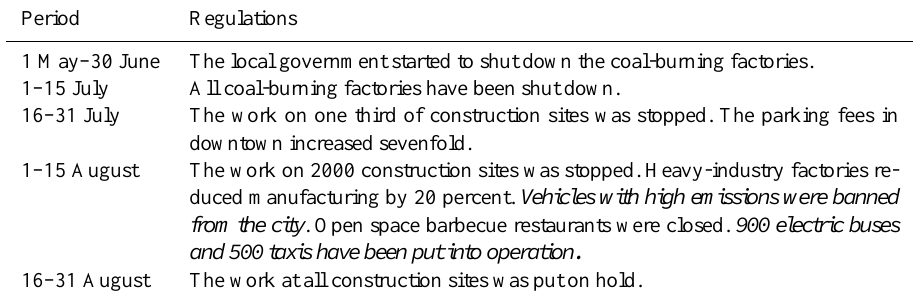
Table 1. Air-quality regulations taken by the Nanjing authorities in the year of YOG2014. The period is the start time of different regulations. The italic regulations are still effective after the